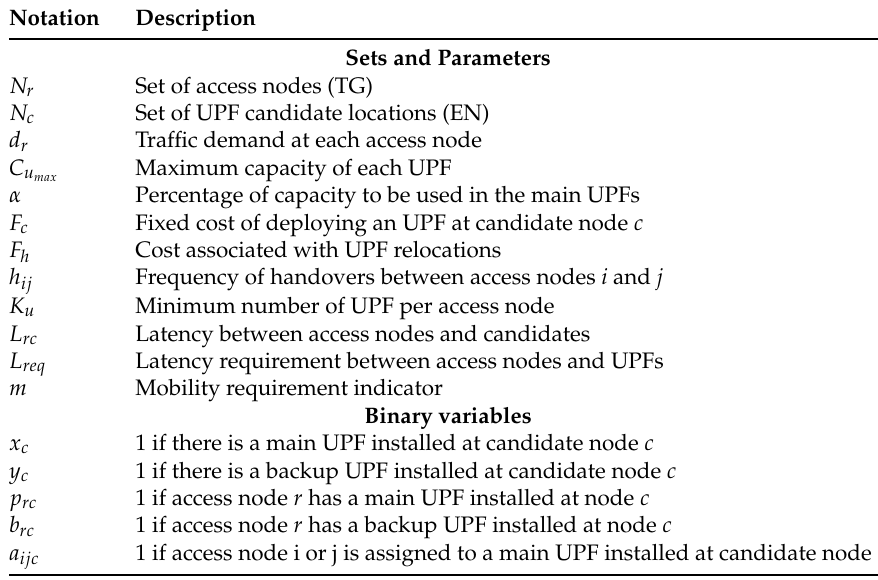
Table 2. Notation used in the UPFPP